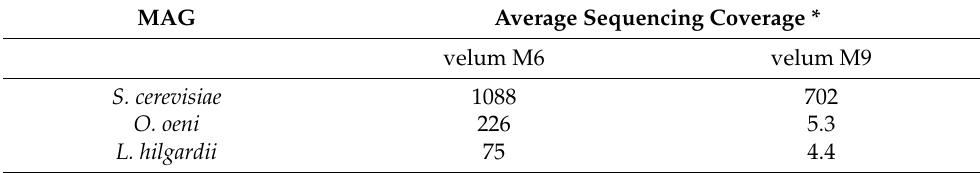
Table 2. MAGs obtained from metagenomes of flor velums. MAG Average Sequencing Coverage